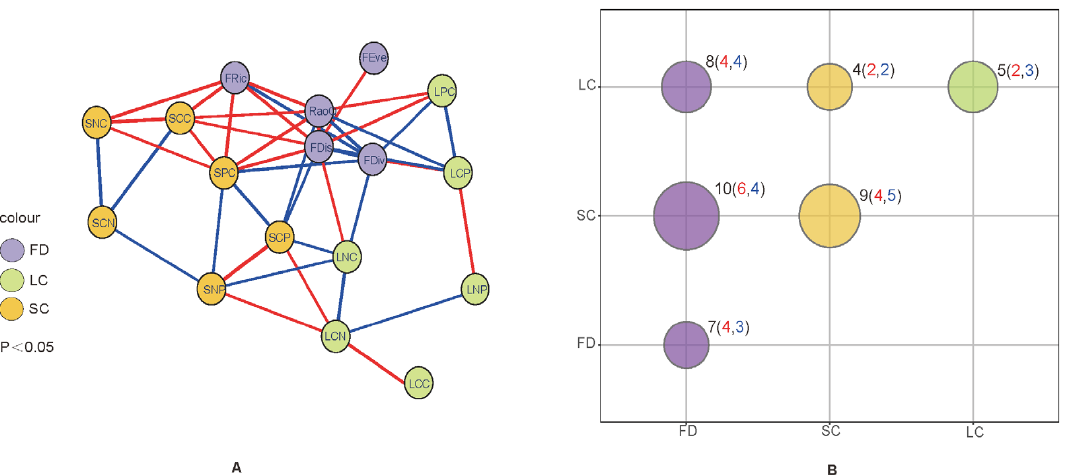
Figure 5. Relationship between functional diversity and leaf and soil ecological chemometric